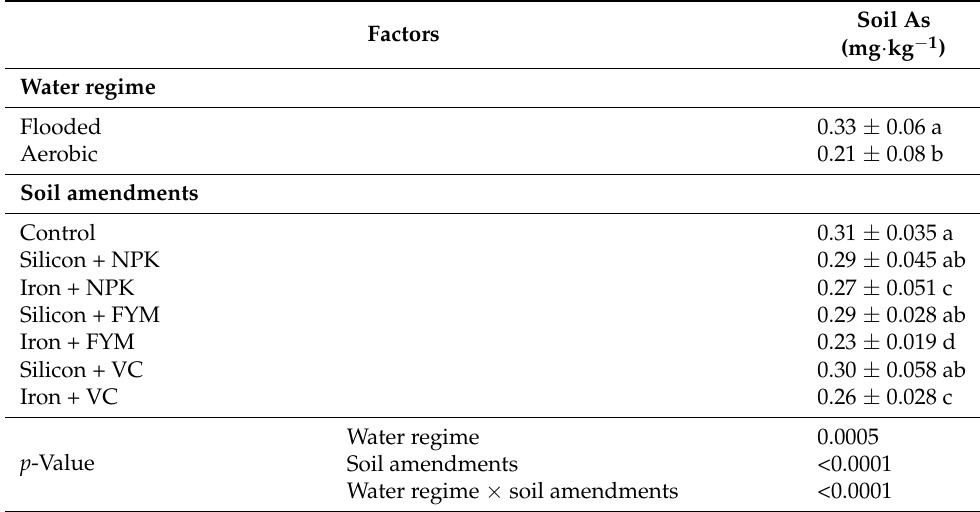
Table 2. Effect of water regimes and amendments on available As concentrations in paddy soils.